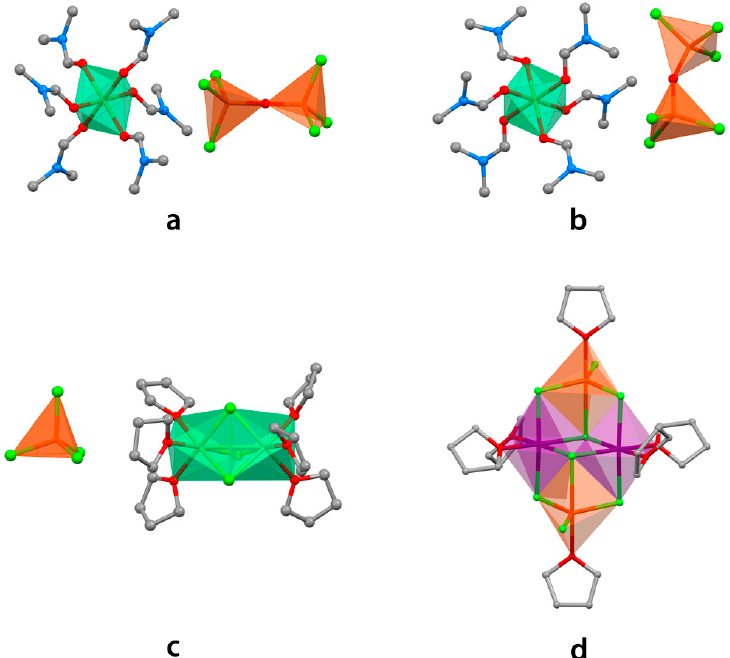
Figure 2. Molecular species per formula unit in the compounds containing both Fe and Ni metals: a , [Ni(DMF) 6 ][Fe 2 ( µ -O)Cl 6 ] 2A ; b , [Ni(DMF) 6 ][Fe 2 ( µ -O)Cl 6 ] 2B ; c , [Ni 2 ( µ -Cl) 3 (THF) 6 ][FeCl 4 ] 3 ; d , octahedra the shared Fe / Ni ones; oxygen atoms are depicted in red, nitrogen in blue, chlorine in light green and carbon in